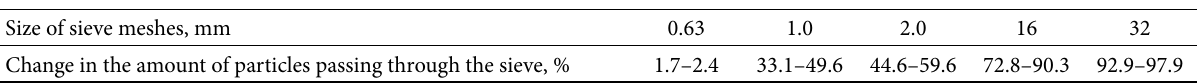
Table 3. Grading of gravel used for the shoulder pavement (Vorobjovas, Žilionienė 2008) Size of sieve meshes, mm